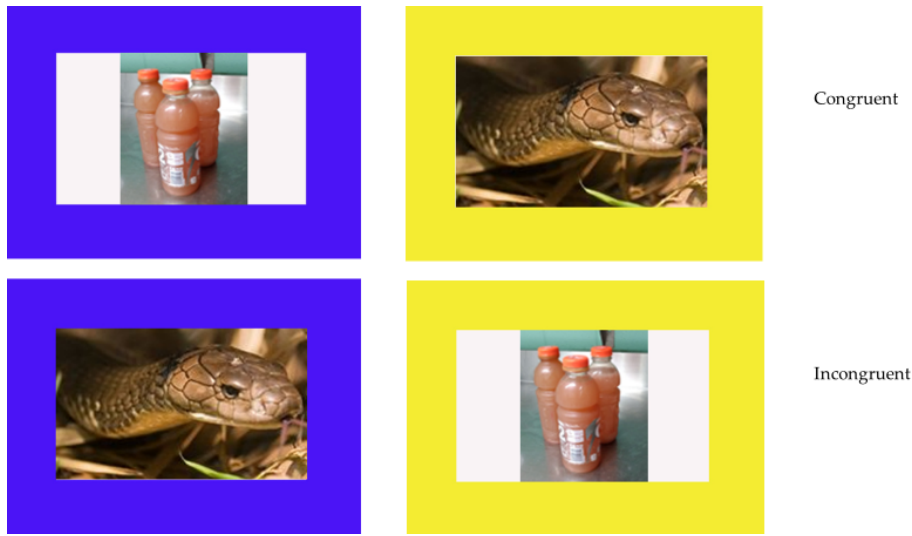
Figure 3. Example of Phase Four trials. Top row shows a congruent trial and bottom row shows an example incongruent trial. The blue border was always correct.